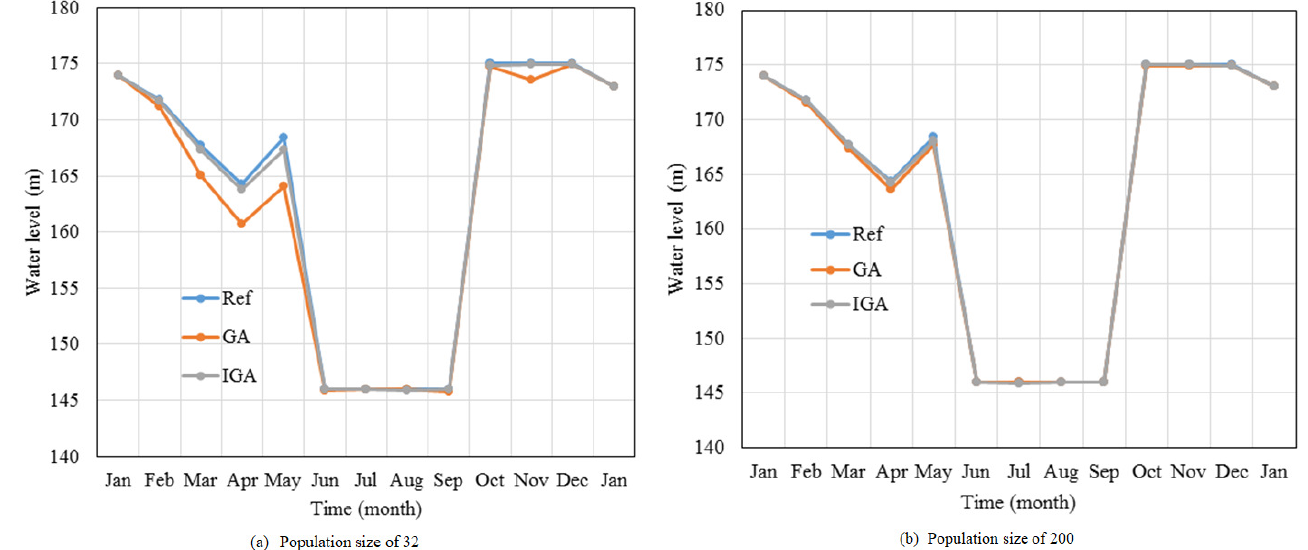
Figure 8. Graphs comparing optimal solutions produced by different algorithms.